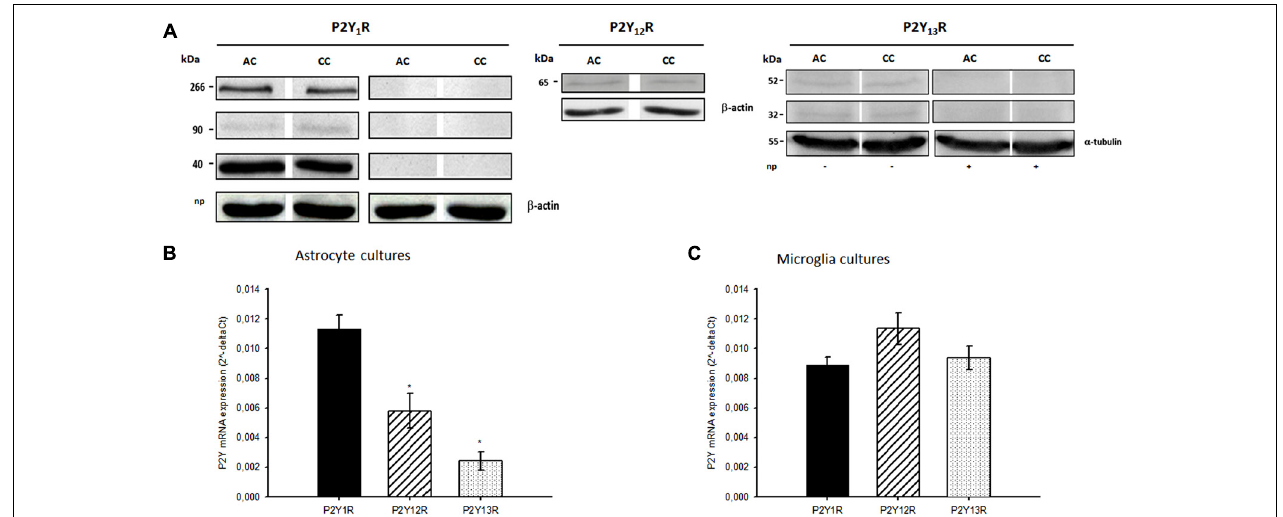
FIGURE 4 | Expression of P2Y 1 , P2Y 12 and P2Y 13 receptors. (A) Representative Western blots of P2Y 1 , P2Y 12 and P2Y 13 receptors (P2Y 1 R, P2Y 12 R and P2Y 13 R) expression in astrocyte-microglia co-cultures (CC) and astrocyte cultures (AC). P2Y 1 R, P2Y 12 R and β -actin (43 kDa) expression data previously published by Quintas et al. (2011a,b). P2Y 13 receptors (P2Y 13 R) and α -tubulin (55 kDa) expression were obtained from whole cell lysates. Two immunoreactive bands of 32 and 52 kDa specifically reacted with rabbit anti-P2Y 13 antibody. These bands were absent in the presence of the respective neutralising peptide (np). mRNA expression of P2YR in (B) astrocyte cultures and (C) microglia cultures. mRNA P2YR expression were determined using qRT-PCR and normalized to GAPDH (astrocytes cultures) or β -actin (microglial). Values are means ± SEM from 3 different cultures. ∗ P < 0.05, significant differences from P2Y 1 R